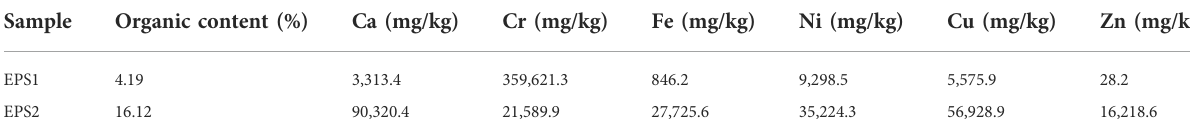
TABLE 1 Main composition of the electroplating sludge.